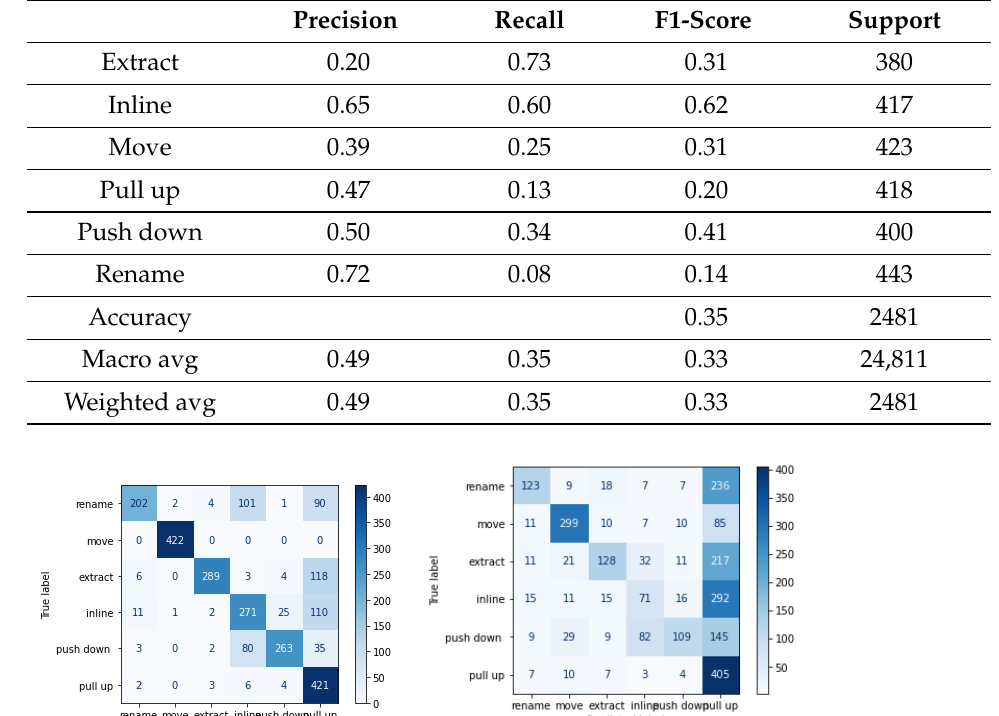
Table 10. Results of Naive bayes model.